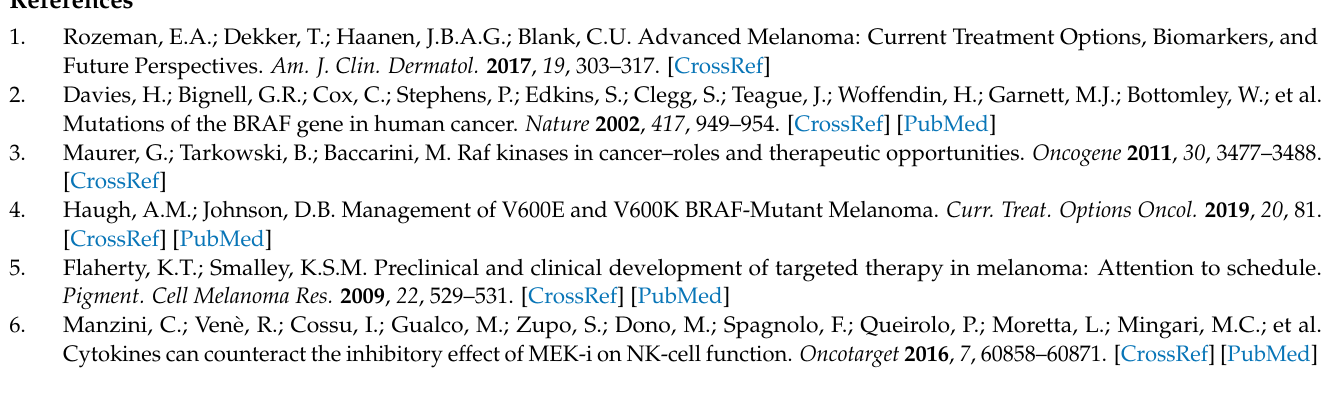
tosis; Figure S3: Human melanoma cores; Figure S4: List of 84 cancer related proteins; Figure S5: Suppression of HMOX1 in WM983B; Figure S6: BRAF V600E and BRAF V600E -NLS expression in MEF -/- BRAF cells; Figure S7: NRF2 expression; Figure S8: Cell fractionations from SKMel-28 cells; Figure S9: mRNA HMOX1 expression; Figure S10: Tumors size; Figure S11: BRAF localization in SKMel-28 and SKMel-202